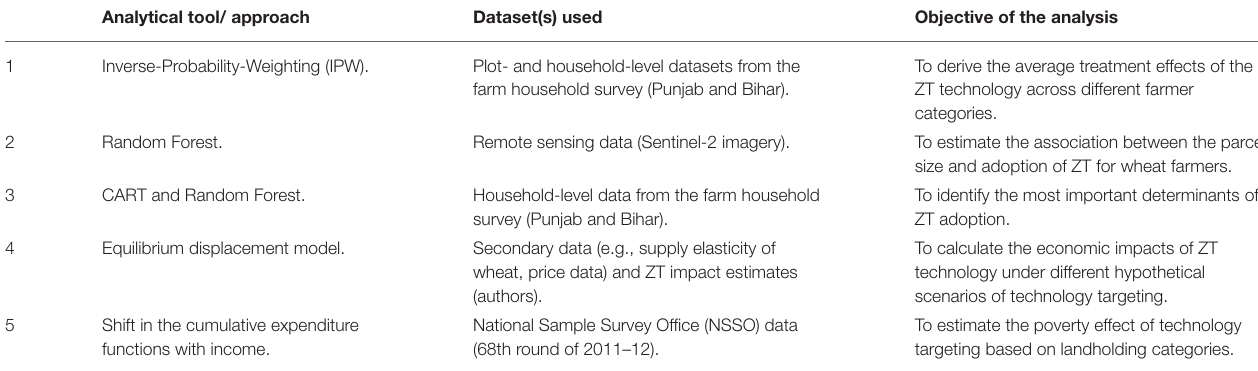
TABLE 1 | Analytical overview. Analytical tool/